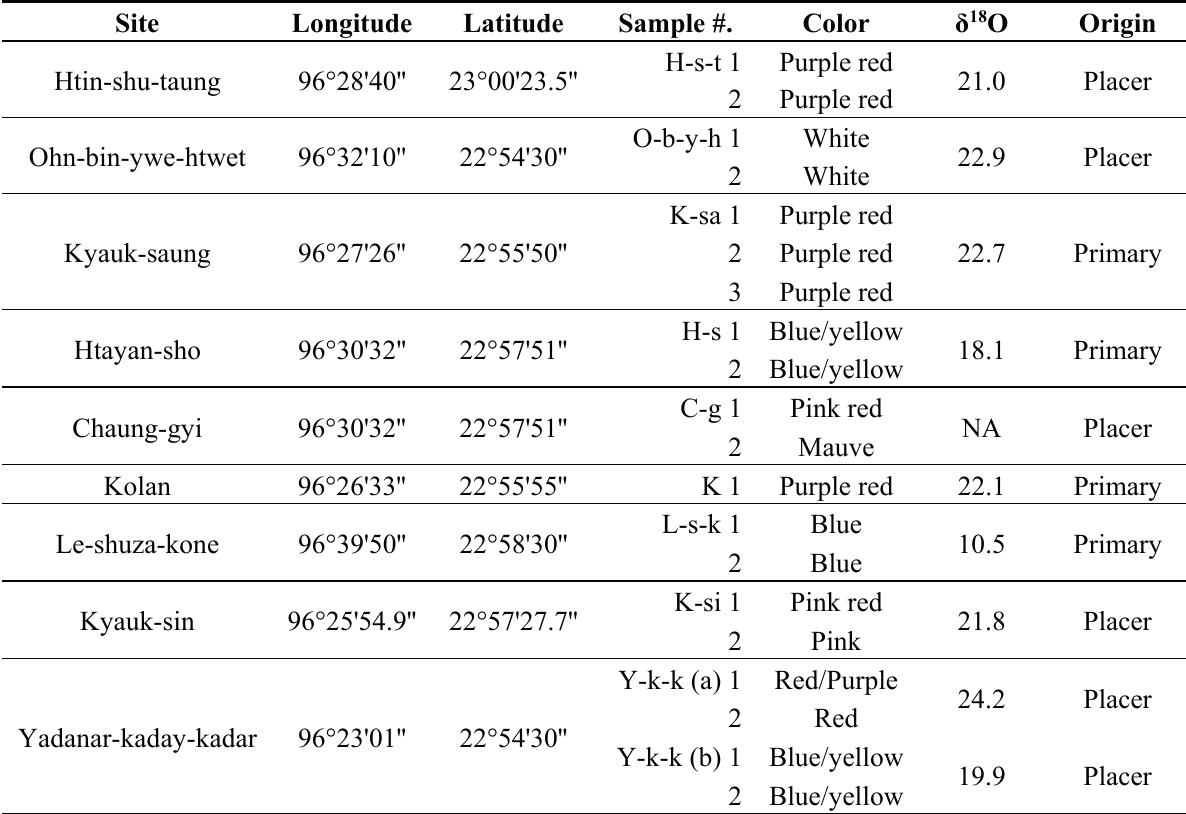
Table 1. Mine sites, locations and sample character, Mogok area gem